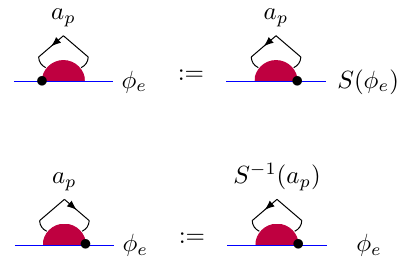
Figure 9 . We consider first the simplest tensor depending on a single edge (decorated by φ e ) bounding a single face (decorated by a p ). This can be viewed as a tensor of rank 2. The trace of the tensor is obtained by forming the virtual loop and using the canonical pairing between H ∗ and H cop . Geometrically this can be interpreted as the degenerate graph of a single edge bounding a single face.